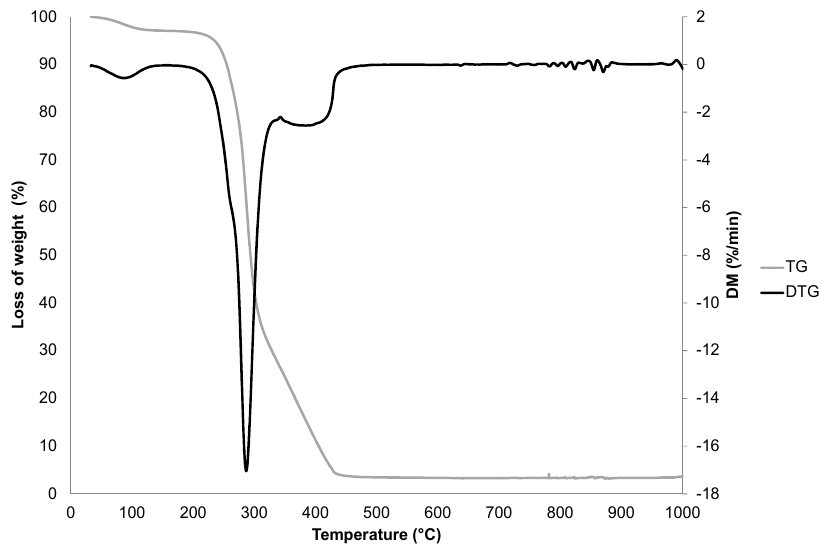
Figure 4. TG and DTG curves of the